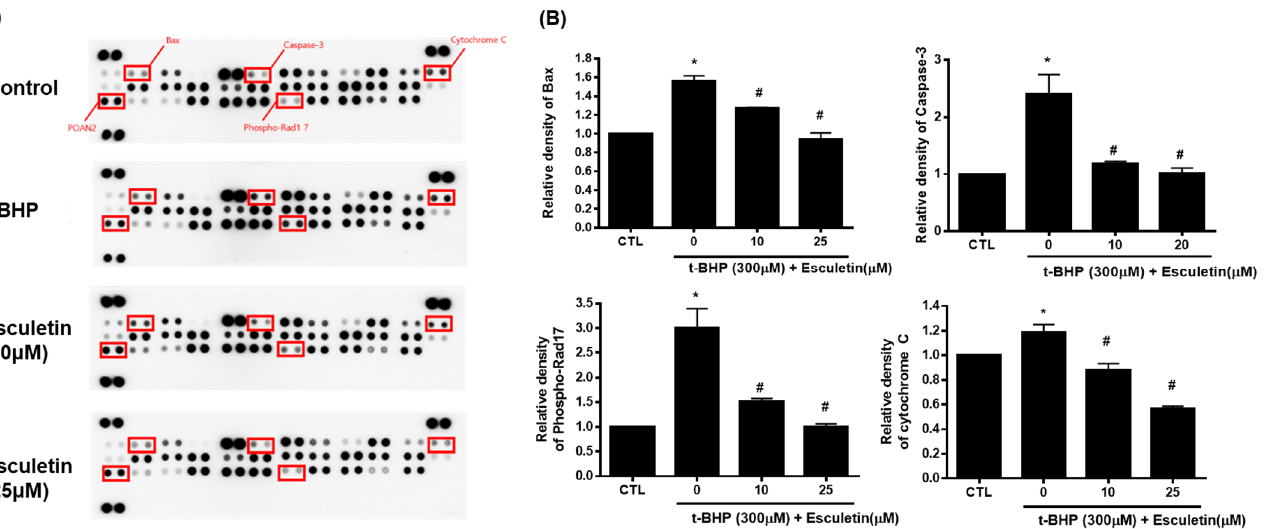
Figure 4. Effect of esculetin on apoptosis-related signaling pathways in HEK293 cells. ( A ) Apoptosis-related protein assay. ( B ) In the bar graphs, the values represent means ± SD, n = 5. * p < 0.05 vs. untreated control group, # p < 0.05 vs. t-BHP-treated group.